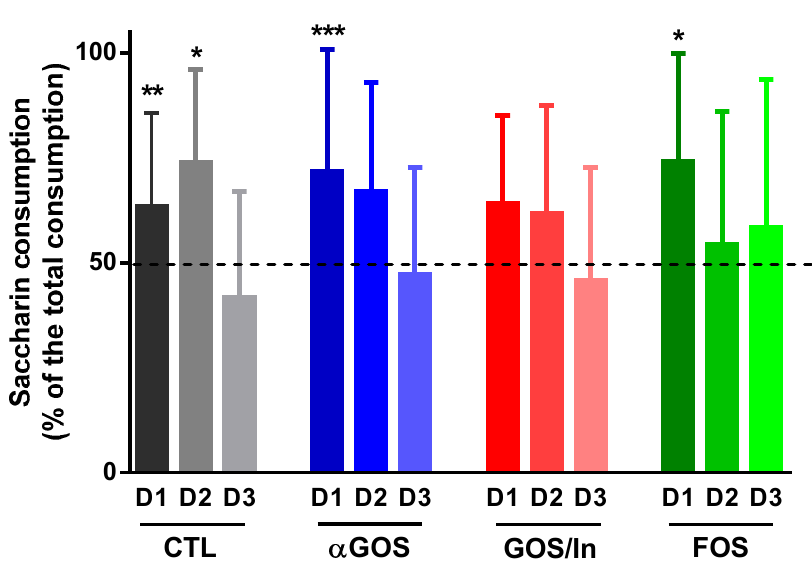
Figure 10. Preference for sweet taste. Data are means ± SD ( n = 7 to 8). Asterisks represent significant preference as compared with no preference (i.e., 50%, dotted line): *, p < 0.05; **, p < 0.01; ***, p < 0.001.